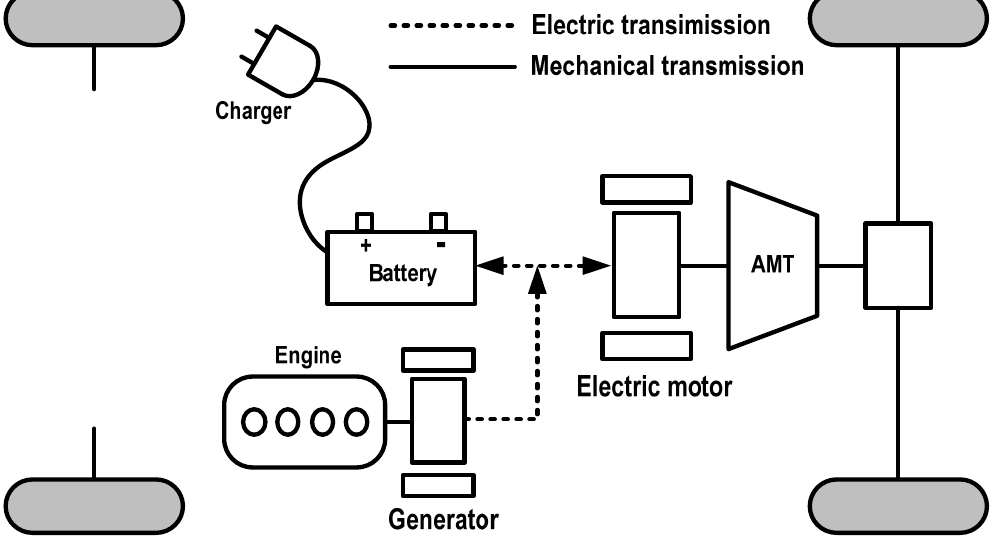
Figure 1. Schematic diagram for powertrain system of plug-in hybrid electric vehicle